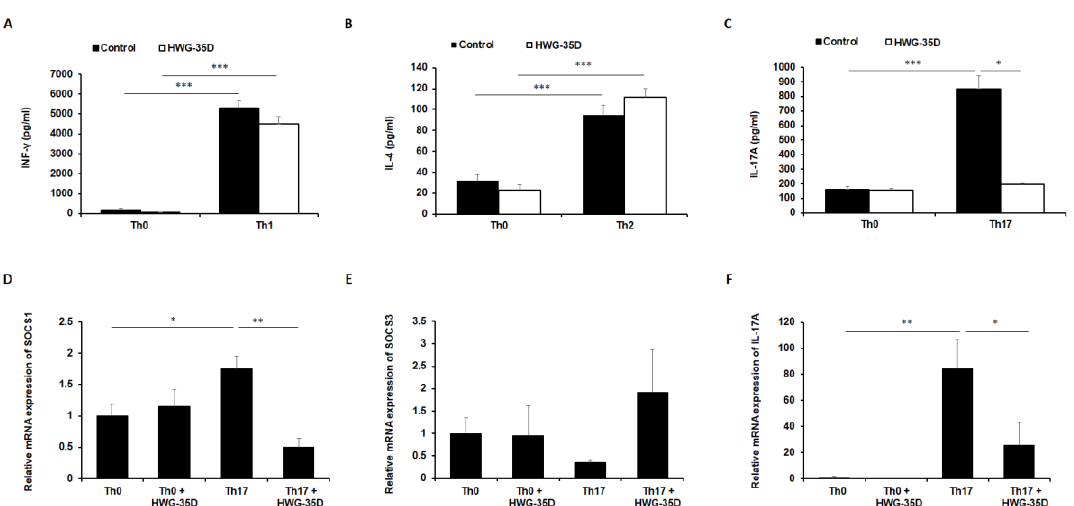
Figure 4. Th17 differentiation of naïve CD4+ T cells is inhibited by HWG-35D. Naïve CD4 + T cells isolated from the mouse spleen were polarized using differentiating media into Th1, Th2, and Th17 CD4 + T cells as described in the material and methods section. ( A ) IFN-γ, ( B ) IL-4, and ( C ) IL-17A levels secreted from differentiated CD4 + T cells were measured using ELISA. The mRNA expression levels of ( D ) SOCS1, ( E ) SOCS3, and ( F ) IL-17A were analyzed using real-time PCR in differentiated Th17 murine CD4 + T cells. Data are mean ± S.E.M. values ( n = 6). * p < 0.05, ** p < 0.01, *** p < 0.001.